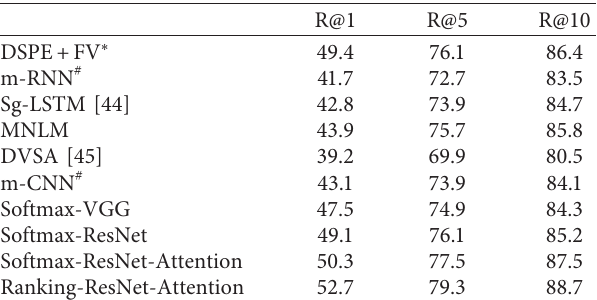
Table 2: Results of caption-image retrieval on the Microsoft COCO dataset.